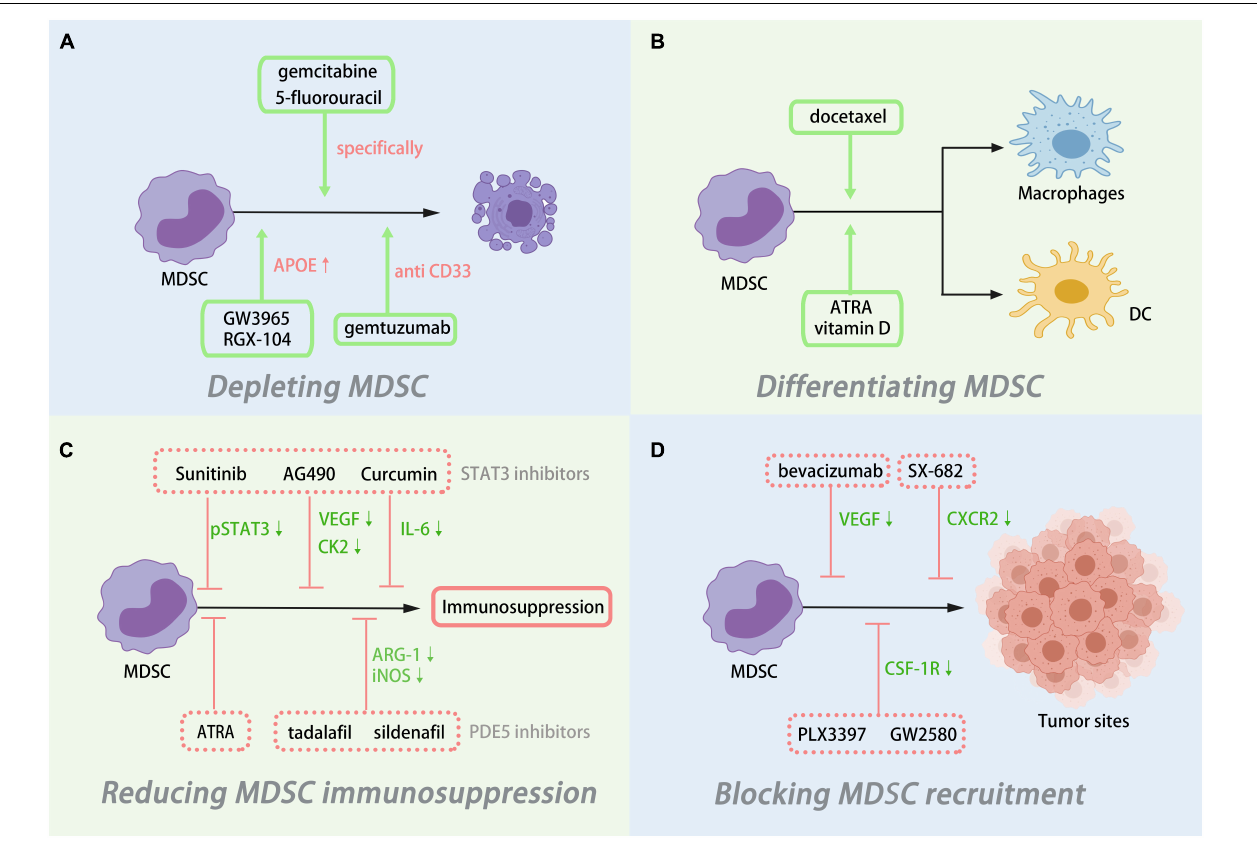
FIGURE 2 | Myeloid-derived suppressor cells (MDSCs) as therapeutic targets in tumor. MDSC modulation could be achieved by (A) depleting MDSC, (B) differentiating MDSC, (C) reducing MDSC immunosuppression, and (D) blocking MDSC